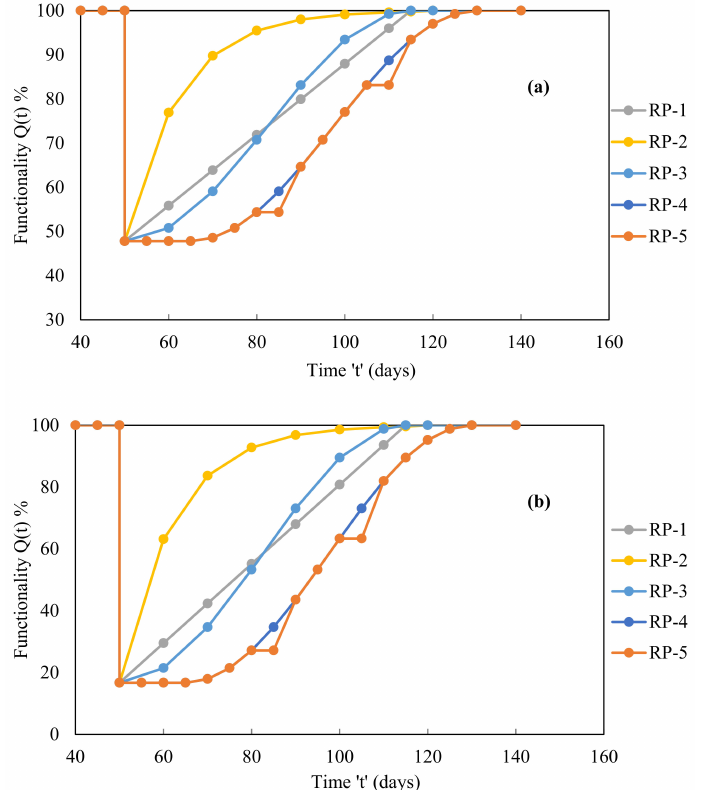
Figure 19. Functionality curves for unsymmetrical building Case III (R = 4) using various recovery paths ( a ) with respect to DBE level and ( b ) with respect to MCE